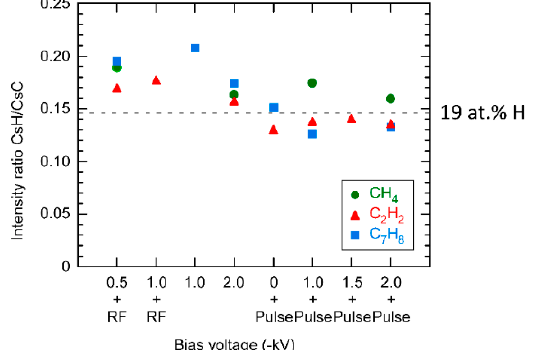
Figure 3. Relative hydrogen content of the single DLC layers prepared with different conditions as indicated. The dashed line indicates the intensity ratio of a sample with 19 at.% hydrogen, as determined by elastic recoil detection analysis.